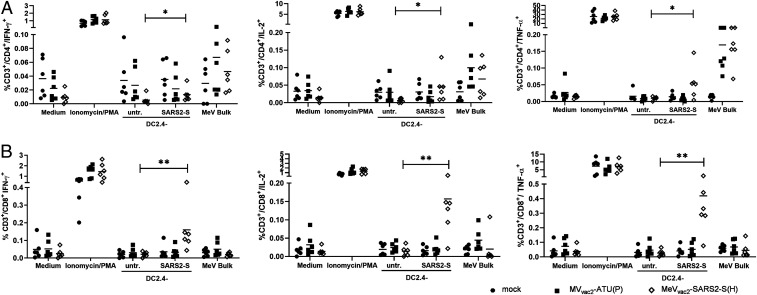
Detection of multifunctional T-cell responses induced by vaccination with MeVvac2-SARS2-S(H). Harvested splenocytes of MeVvac2-SARS2-S(H)−vaccinated mice (same as depicted in Fig. 3) were restimulated and subjected to intracellular staining (ICS) for IFN-γ (Left), TNF-α (Right), and IL-2 (Middle), and stained for extracellular T-cell markers CD3, CD4, and CD8 for flow cytometry analysis. Quantification of flow cytometry data of (A) CD4+- and (B) CD8+-positive T cells after coculture with antigen-presenting DC2.4-SARS2-S or parental DC2.4 control cells, or after incubation with indicated stimuli (MeV bulk antigen [MeV bulk], or untreated cells [mock]); reactivity of splenocytes was confirmed by Ionomycin/PMA treatment (10 μg/mL). Dots represent individual animals; horizontal bars are mean. Mann−Whitney test was used to compare cytokines levels between DC2.4 and DC2.4-SARS2-S restimulated splenocytes in the MeVvac2-SARS2-S(H) vaccine group without correction for multiple testing, because of the exploratory character of the study. *P < 0.05; **P < 0.01.